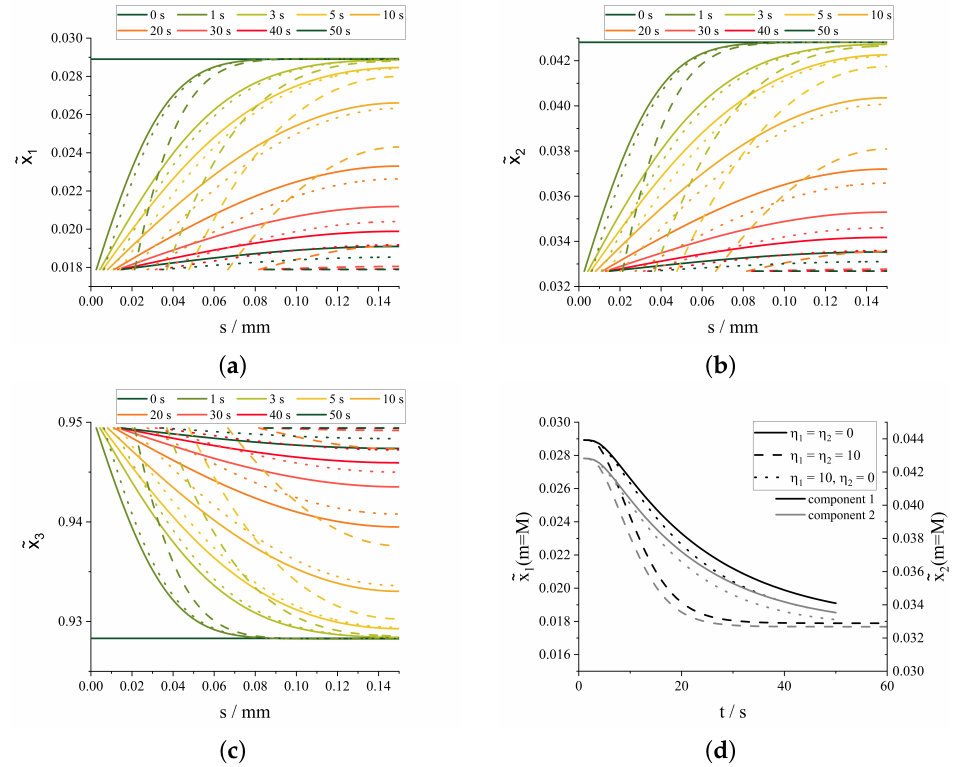
Figure 7. Time and space evolution of molar fractions of component 1 ( a ), 2 ( b ), and 3 ( c ) in solution. Diagram ( d ) depicts the development of the concentration ˜ x i at the point m = M over time. Simultaneous crystallization of component 1 and 2 are shown with different solvation states of either material. Full lines represent cases with no solvation building ( η 1 = η 2 = 0). Dashed lines represent the result if both components solidify as decasolvates ( η 1 = η 2 = 10). The crystallization of a solvate and an ansolvate is given by dotted lines ( η 1 = 10, η 2 =